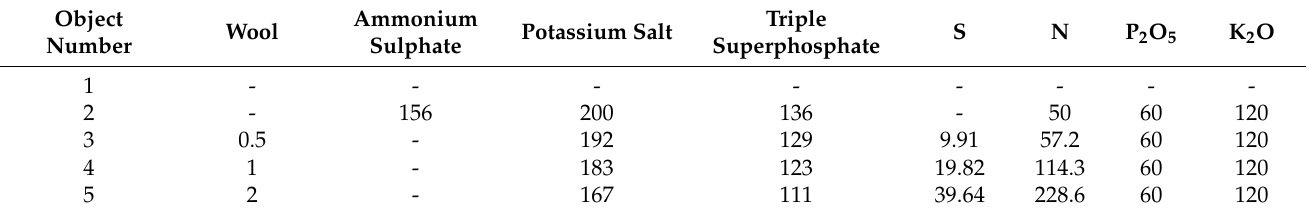
Table 1. Experiment design.